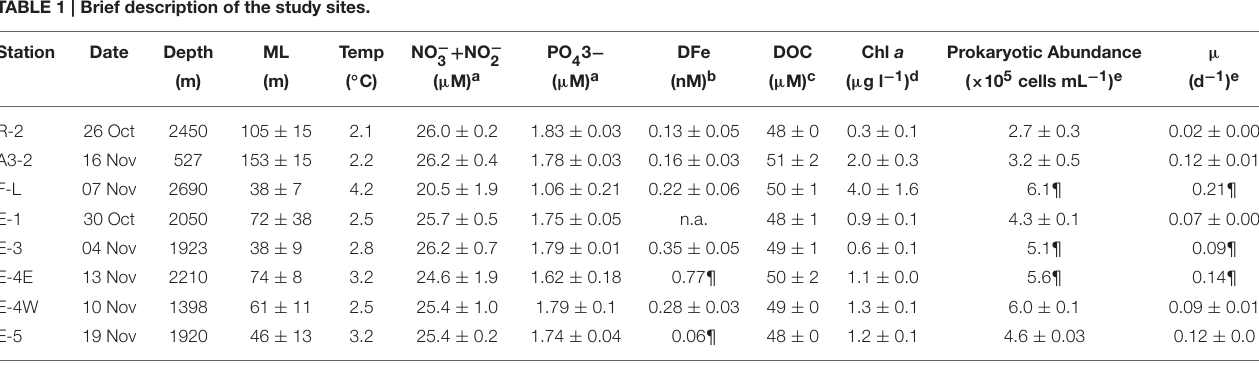
TABLE 1 | Brief description of the study